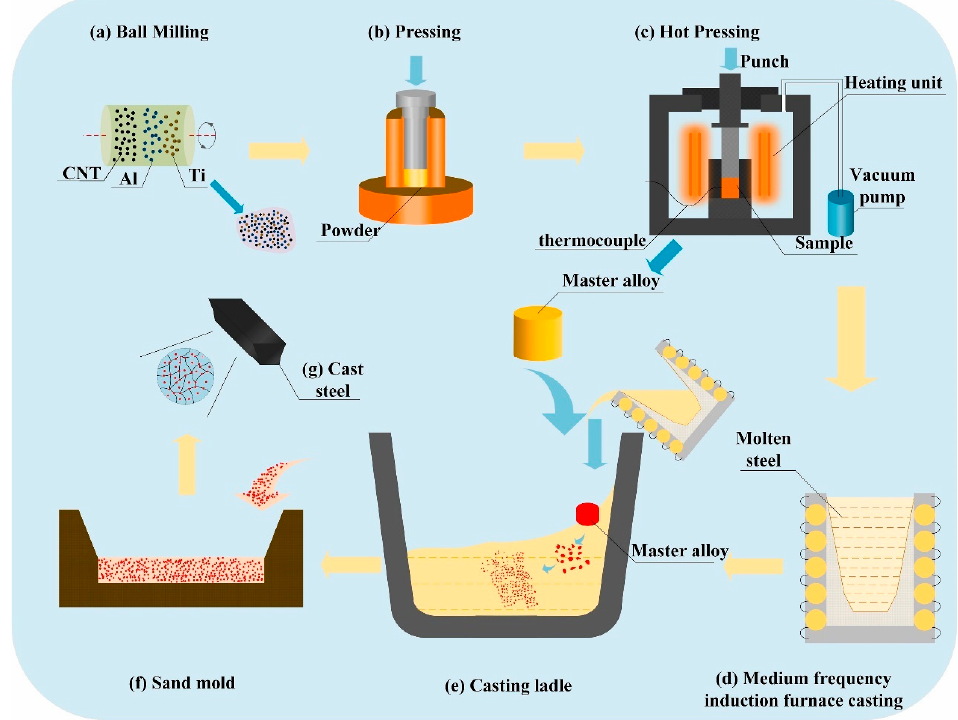
Figure 4. Schematic of the preparation process of the 40Cr steel manipulated by trace TiC nanoparticles, reprinted with permission from ref. [48]. 2022, Elsevier.